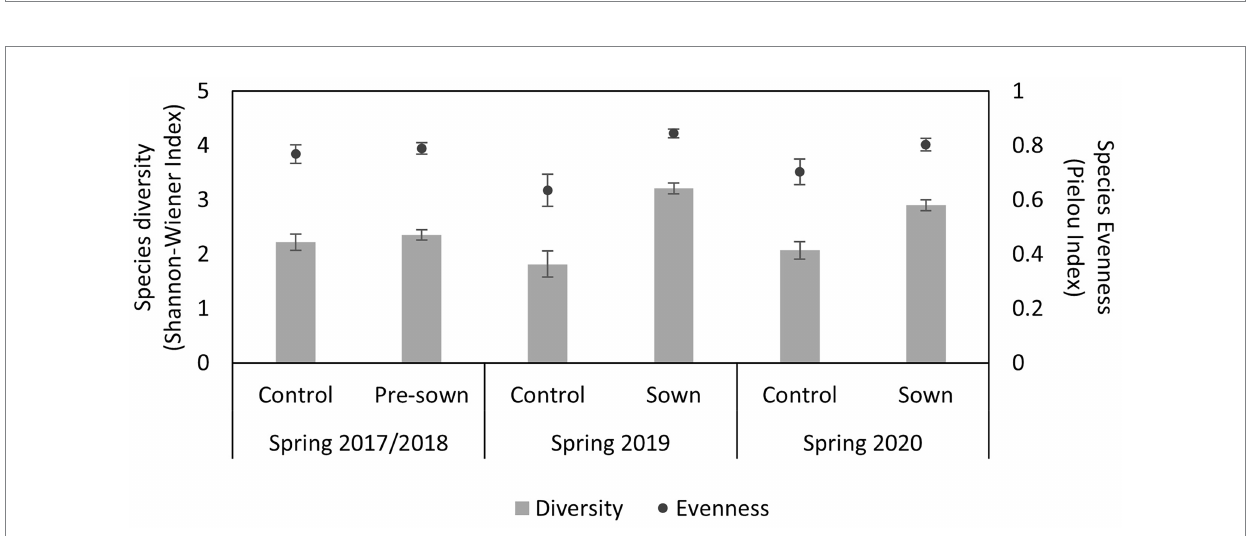
(Table 2), highlighting the increase in total species richness (125%) and diversity